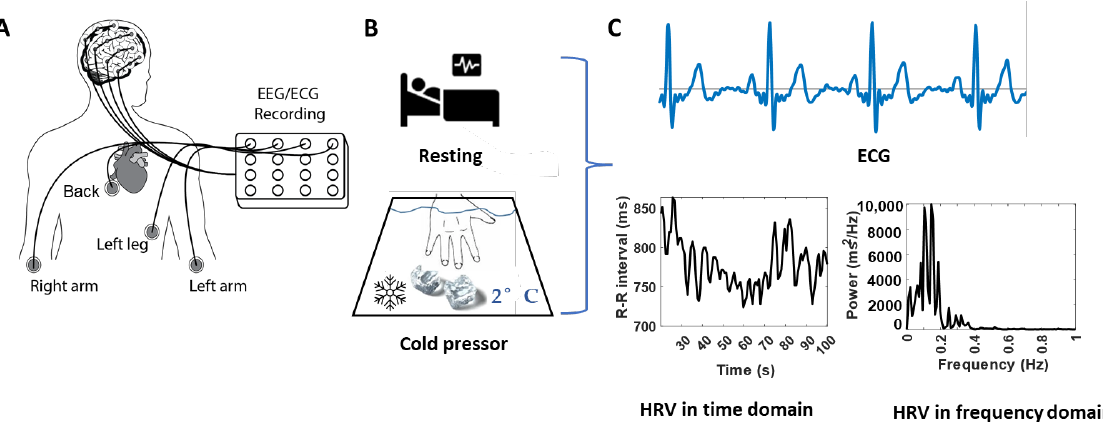
Figure 1. Demonstration of the experimental protocol and representative HRV characteristics from ECG signals. ( A ): Schematic drawing of the combined two 8-channel ADS1299 systems and the ECG electrodes positions. ( B ): Schematic drawing of the tests at the baseline/resting (top panel) and the tonic pain/cold pressor (bottom panel) conditions. ( C ): Standard ECG signals (top panel) and the calculated HRV behavior (bottom panels) in time (left panel) and frequency (right panel) domains.